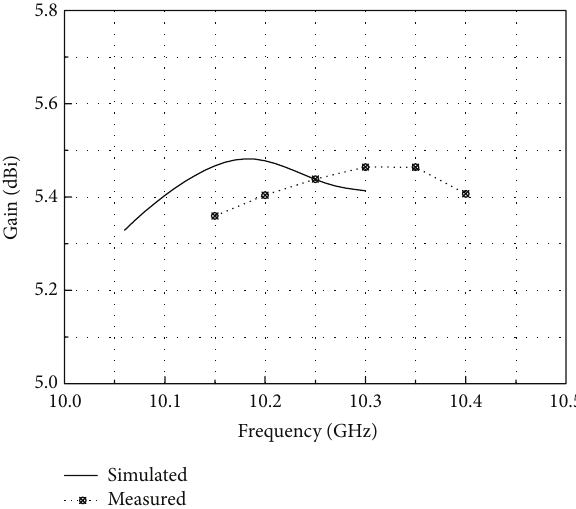
Figure 6: Gain of the fabricated antenna at the boresight